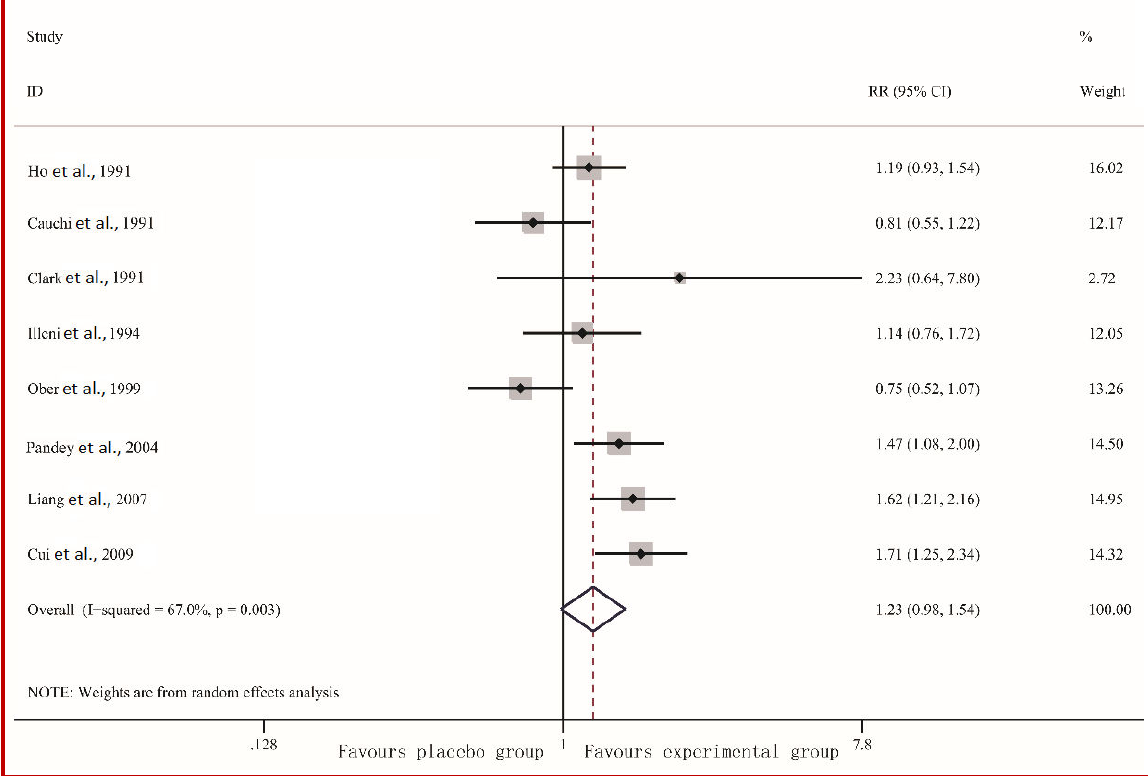
Figure 5: Successful pregnancy rate comparison between paternal or third-party lymphocyte and placebo